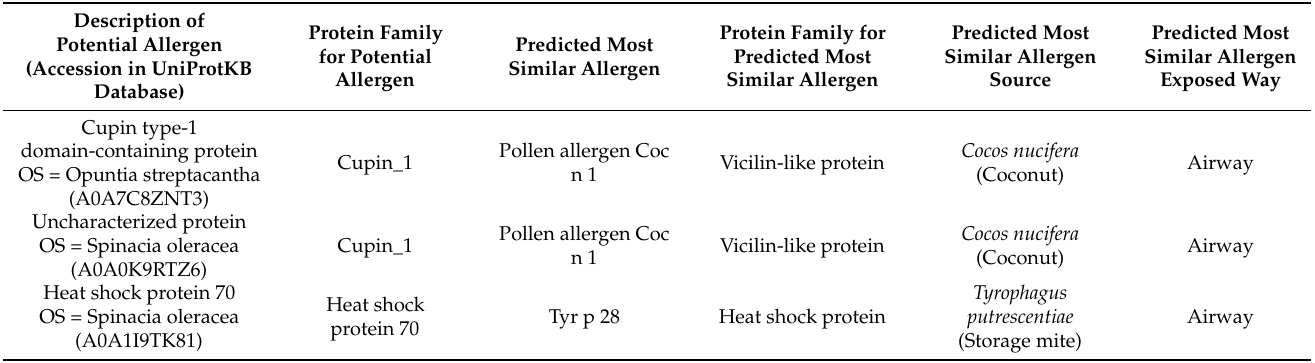
Table 3. Potential allergens from white-fleshed pitaya seeds predicted using three online platforms for protein